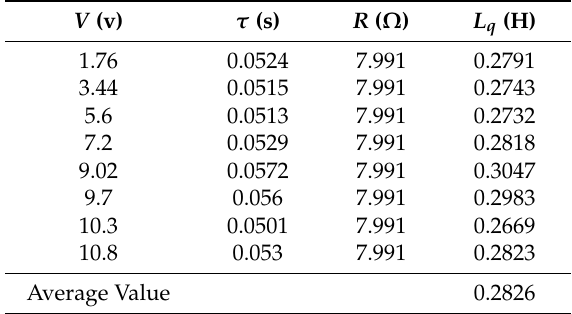
Table 7. Step DC test result- rotor q-axis aligned with phase-a.